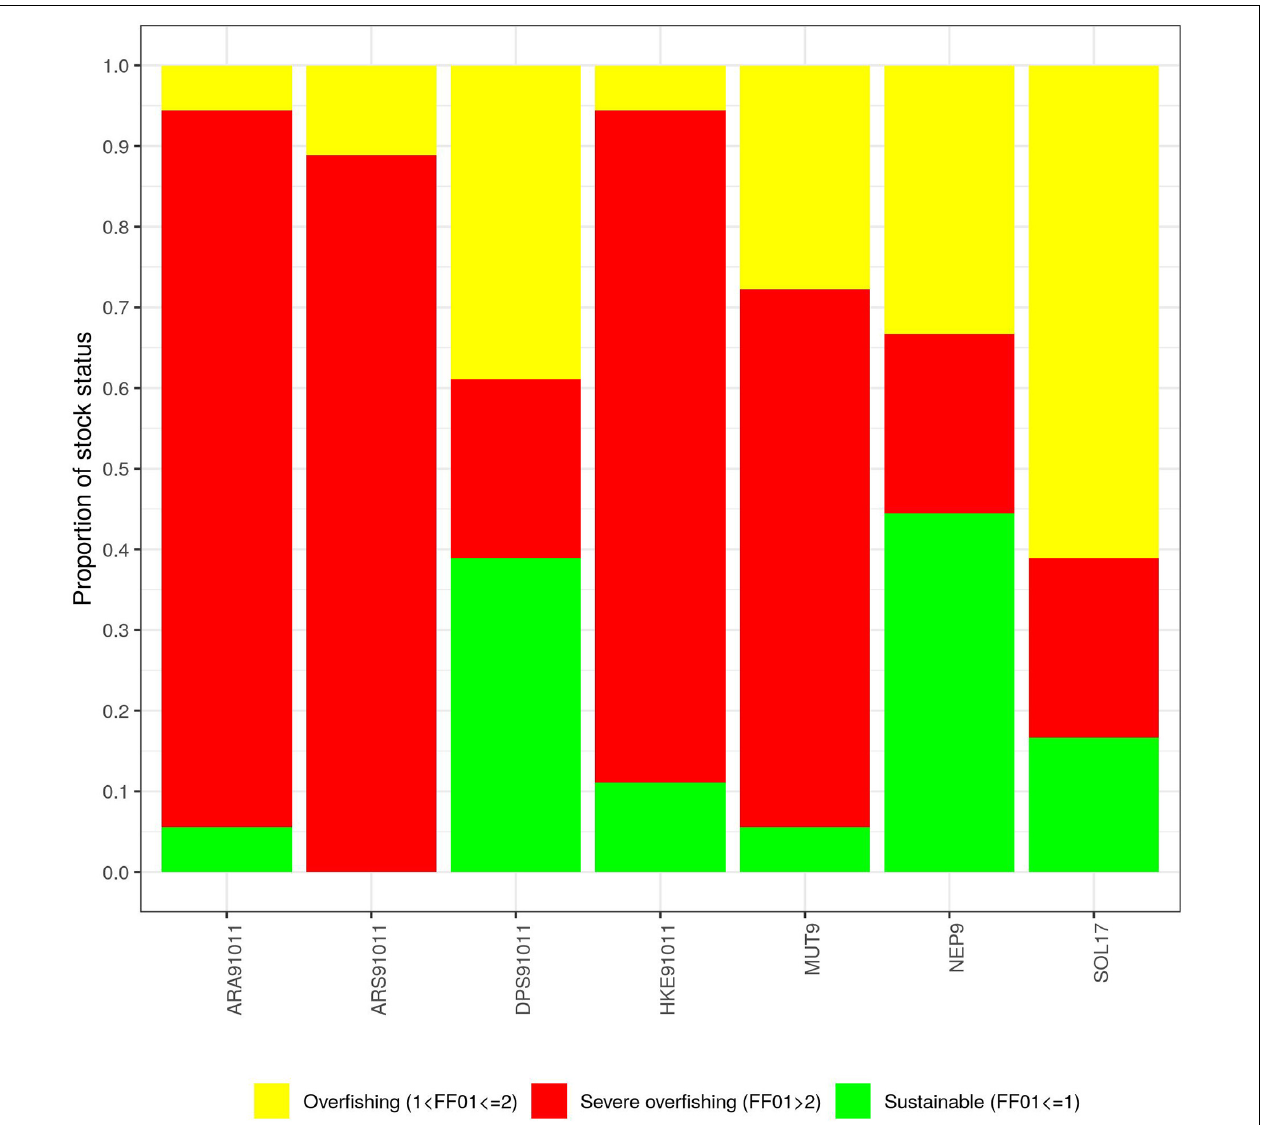
FIGURE 3 | Distribution of the ratios F curr /F 0 . 1 by M estimation method. On the y axis is reported the proportion of stocks for each level of exploitation over the total number of stocks (7).